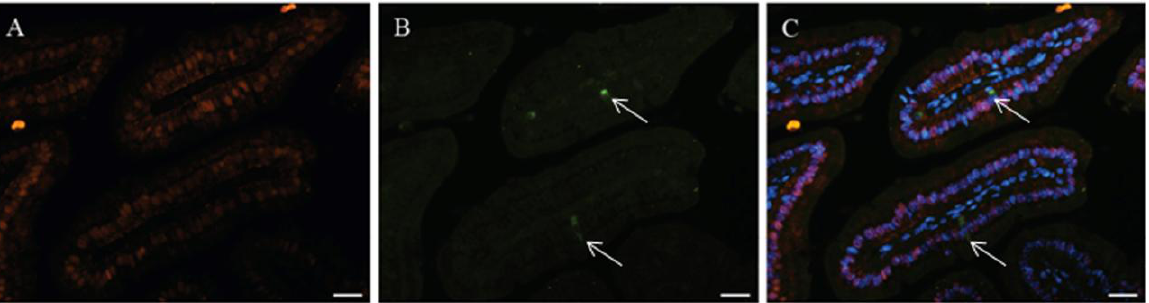
Figure 2. Immuno-histochemical analyses in duodenal villi of mice. A to F , immunoreactive CaBP-9k appears in the cytoplasm of many populations of epithelial cells within the duodenal villi ( A and D , red ) at 100× magnification by immunofluorescence detection. To identify the co-localization between CaBP-9k and other proteins, the specific antibodies for chromogranin A ( B , green ) and E-cadhedrin ( E , green ) were co-incubated with anti-mouse CaBP-9k antibodies using corresponding Alexa-Fluor conjugated secondary antibodies. DAPI ( blue ) was used for nuclei staining. Based on DAPI signals, co-localization of CaBP-9k and each protein is evident by superimposition ( C and F ) of the green and red signals, respectively. HNF-4α (nuclear protein marker, G , Red ) used in an attempt to identify the GR ( H , green ) expression in duodenal enterocytes, both images were merged and observed as blue ( I ). Scale bar = 20